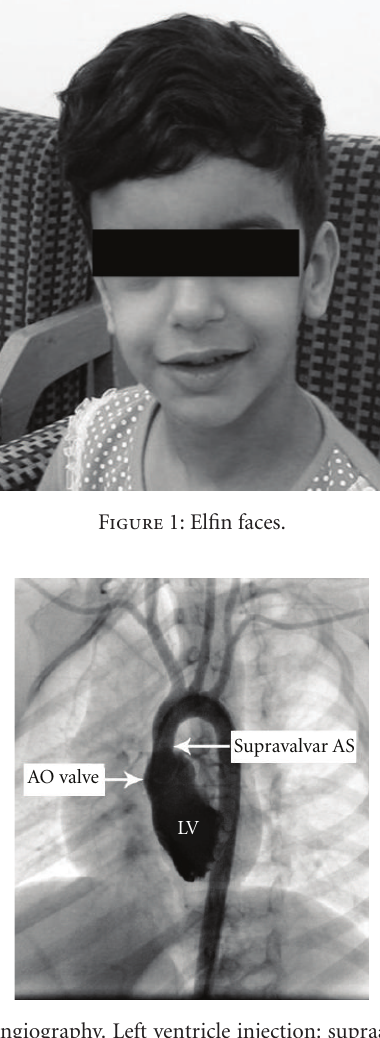
Figure 2: Angiography. Left ventricle injection: supraaortic steno- sis.